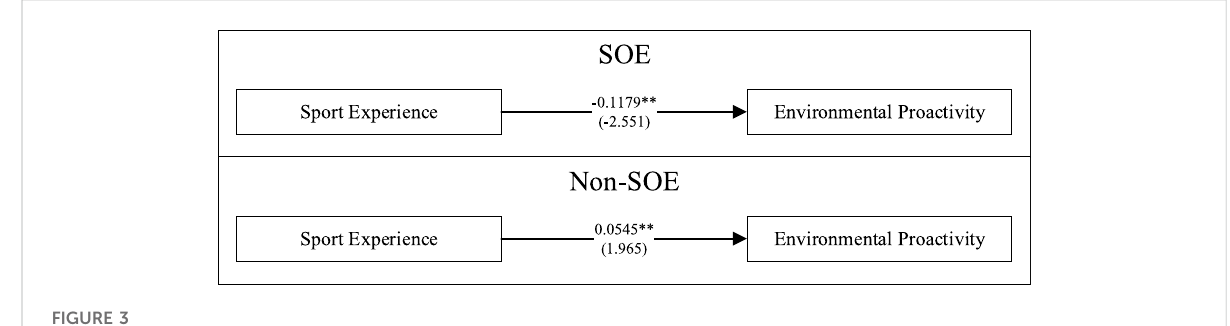
FIGURE 3 Major results of